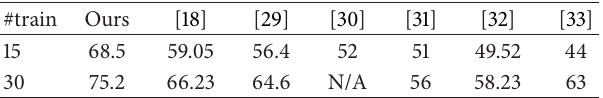
Table 2: Accuracy of